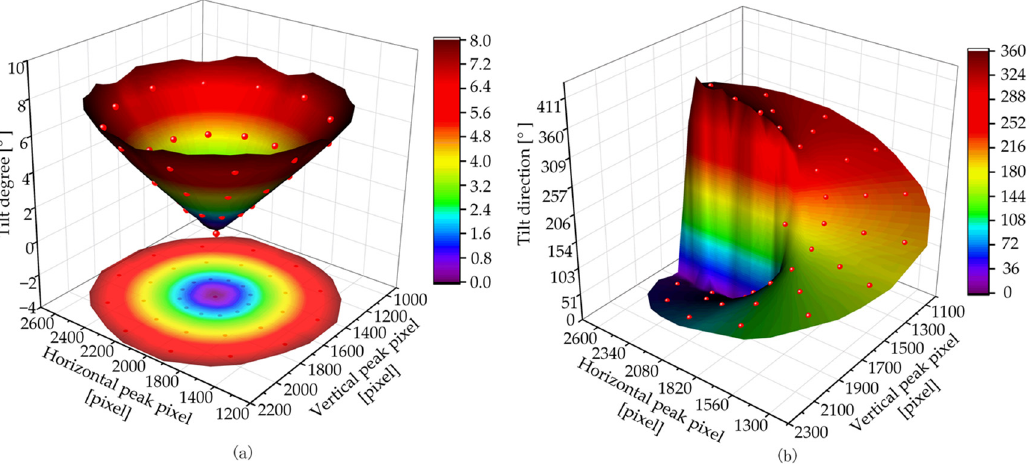
Figure 10. In the equipment calibration experiment, the fitting surface of training set data comprises the relation surface ( a ) between the peak position and θ , and the relation surface ( b ) between the peak position and ϕ